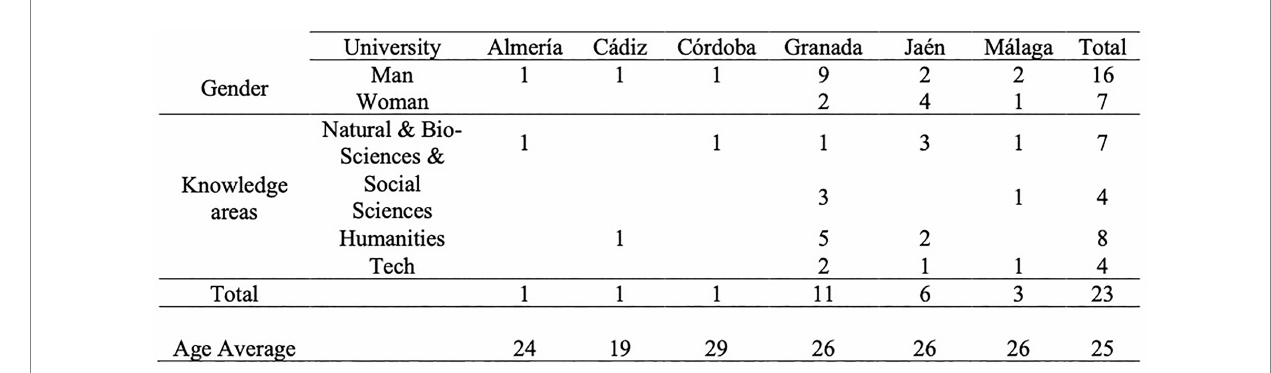
FIGURE 4 Estructura de la muestra.